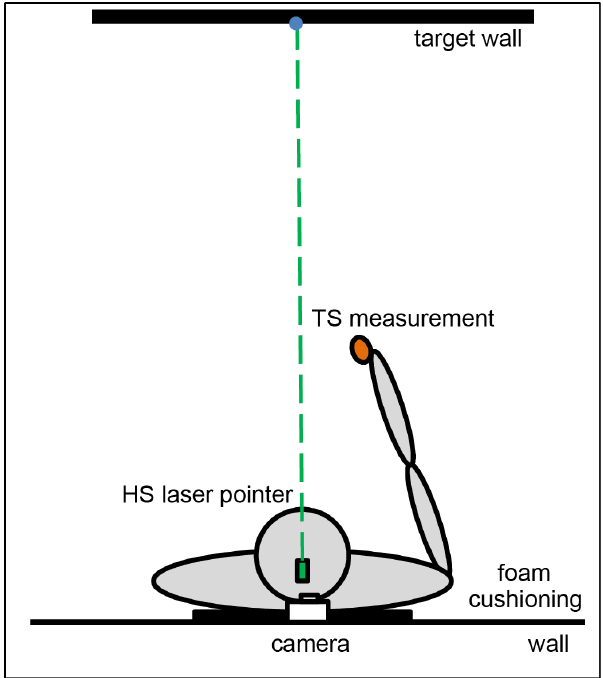
Figure 7. Test set-up for throwing. The participant stood at a wall (black line) with the back at a foam cushioning. The blue dot indicates the central target position (0°). The target wall received beams of the head laser pointer (green) as well as balls for measuring the total straight ahead (orange).